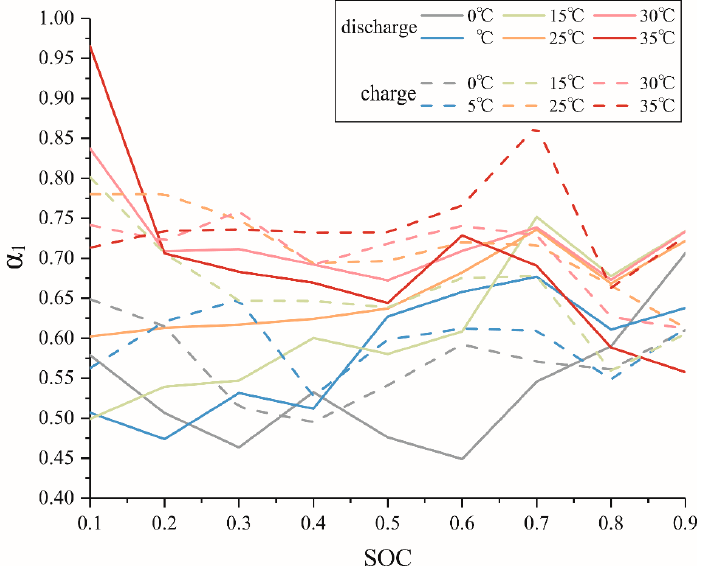
Figure 14. Evolution of the CPE order α 1 as a function of SOC at different temperatures in the range 0–35 °C.